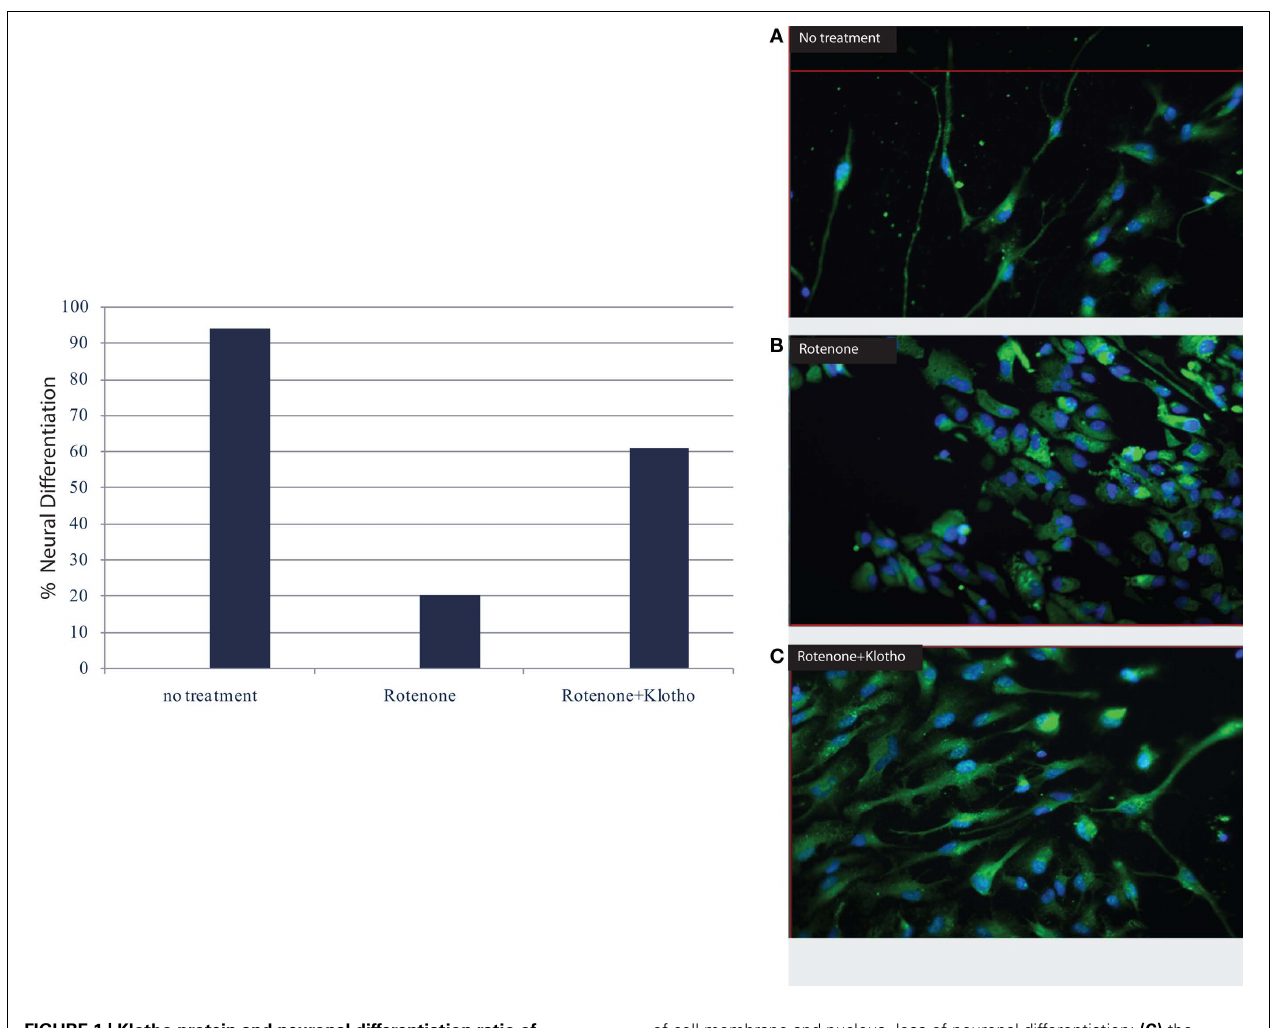
FIGURE 1 | Klotho protein and neuronal differentiation ratio of human neural stem cells (hNSC): NF–M (medium neurofilament protein) vs. astrocyte/GFAP (glial fibrillary acidic protein). (A) no treatment, (B) in the presence of rotenone; apoptosis with destruction